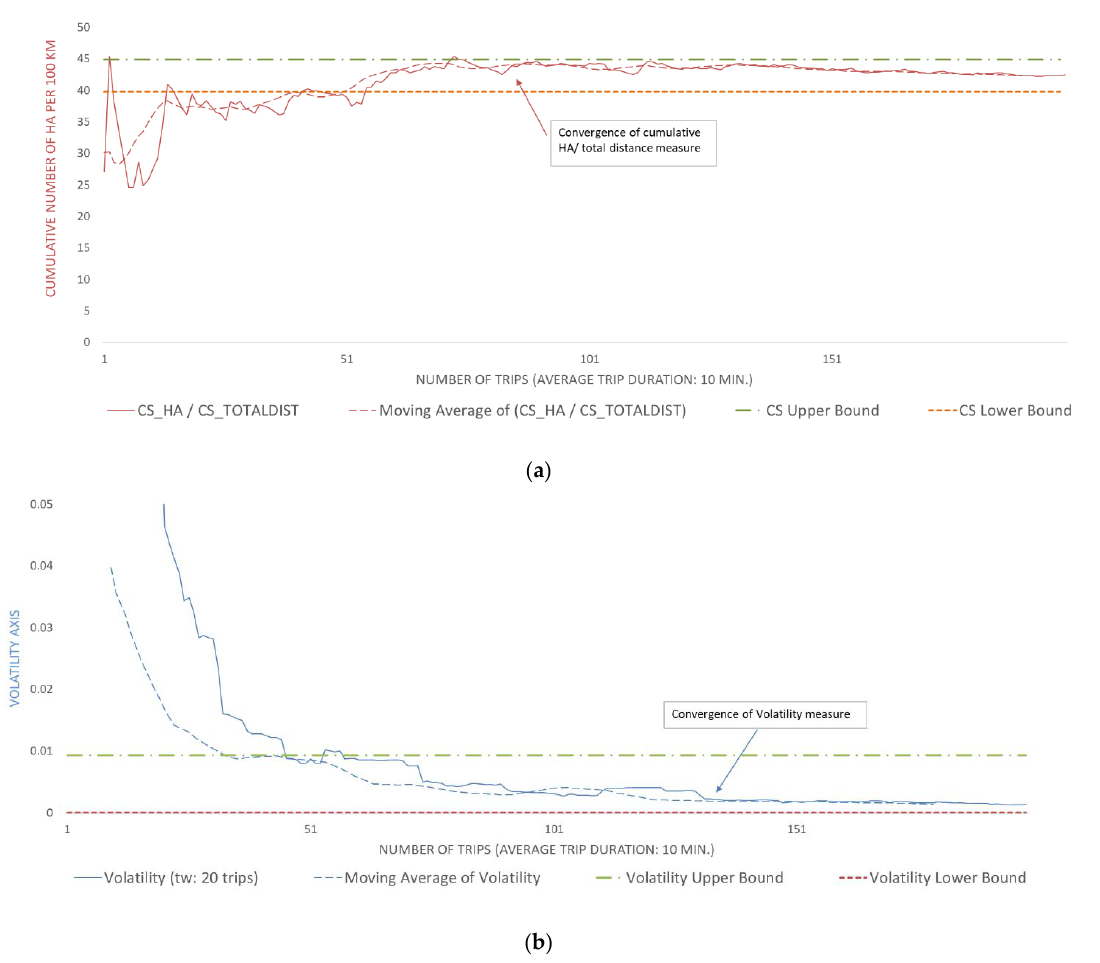
Figure 6. ( a ) Convergence plot of the cumulative harsh acceleration events per km for user “9.” ( b ) convergence plot of the volatility of harsh acceleration events rate for user “9.”